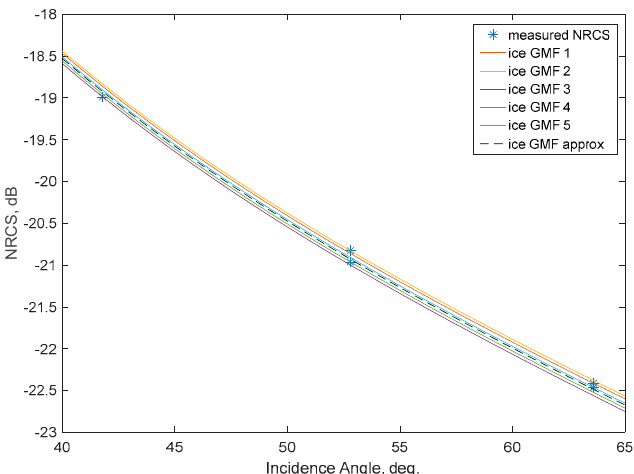
Figure 8. An example sea ice GMF approximation plot from the measured NRCSs for a selected cell by the “old” fore-, mid-, and aft-beams at 52.8°, 41.8°, and 52.8°, respectively, and with the incidence angle for the selected cell by the “additional” fore- and aft-beams of 63.6°.